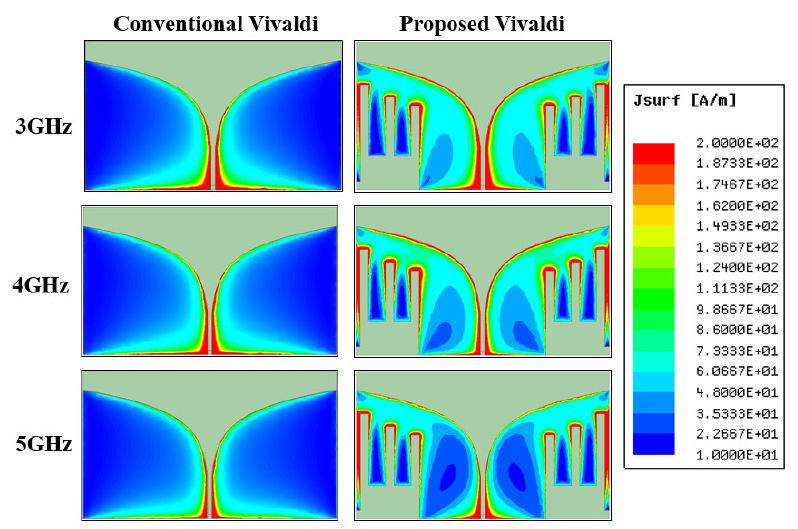
Figure 4. Comparisons of surface current densities of conventional and proposed Vivaldi antennas.